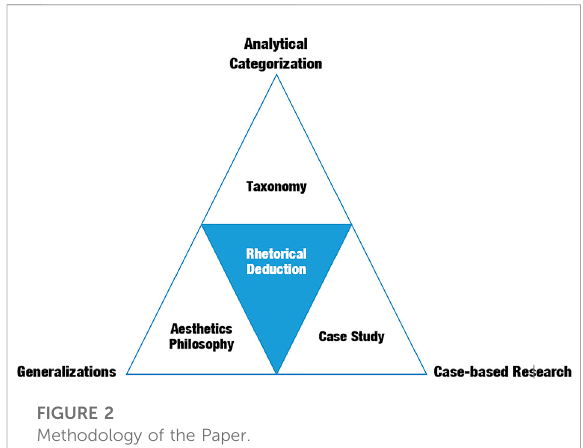
FIGURE 2 Methodology of the